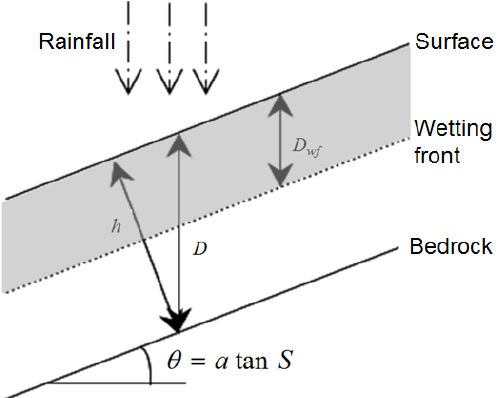
Figure 1. Schematic figure showing the concept of the wetted depth ratio considering a wetting front in the